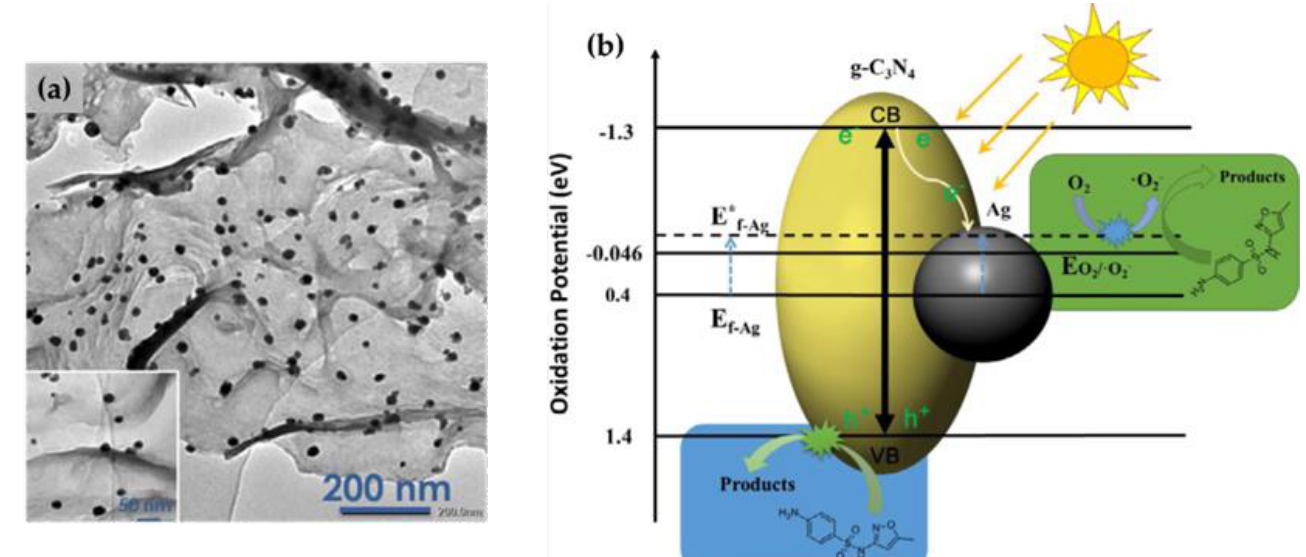
Figure 2. TEM image of Ag/g-C 3 N 4 nanocomposite ( a ), photocatalytic mechanism of the Ag/g-C 3 N 4 heterostructure ( b ). Reprinted with permission from [63]. Copyright 2018, Elsevier.